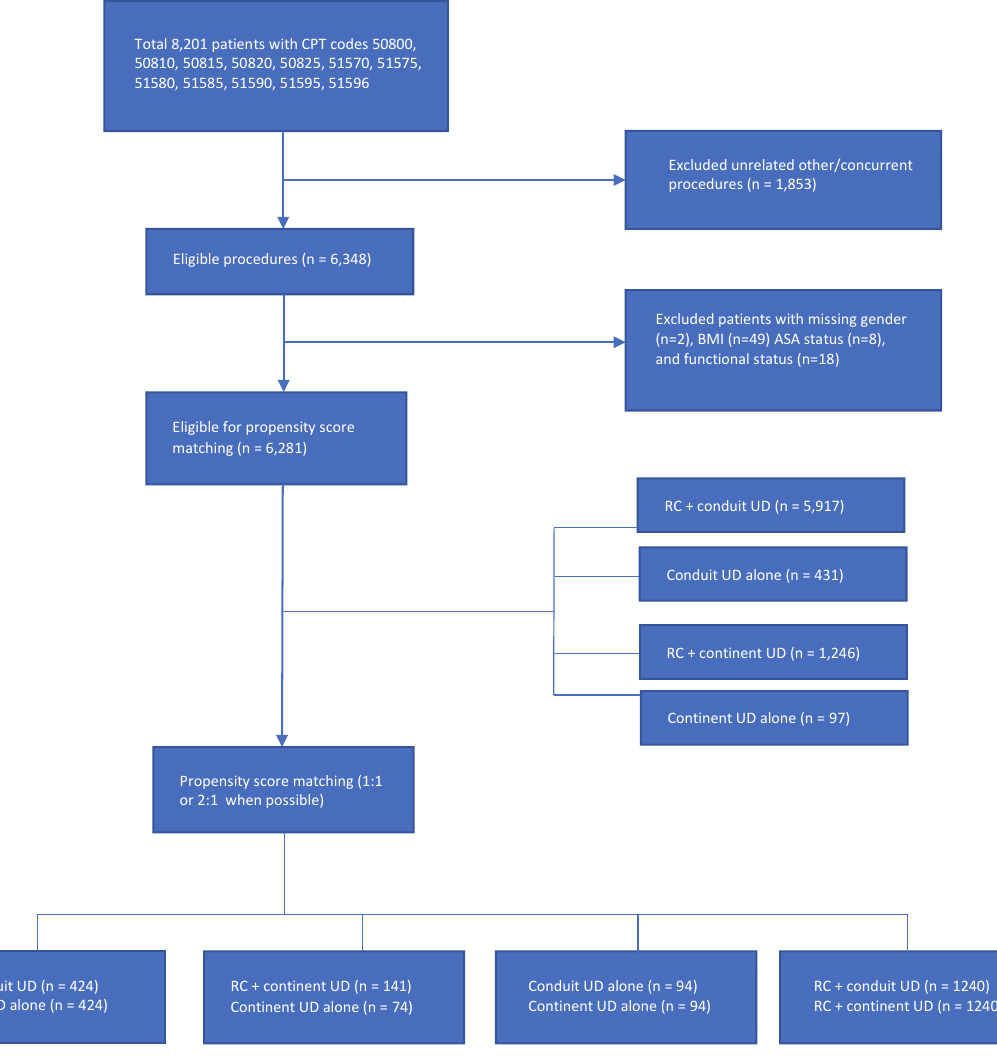
Supplemental Figure-1 - Flowchart detailing patient selection and reasons for